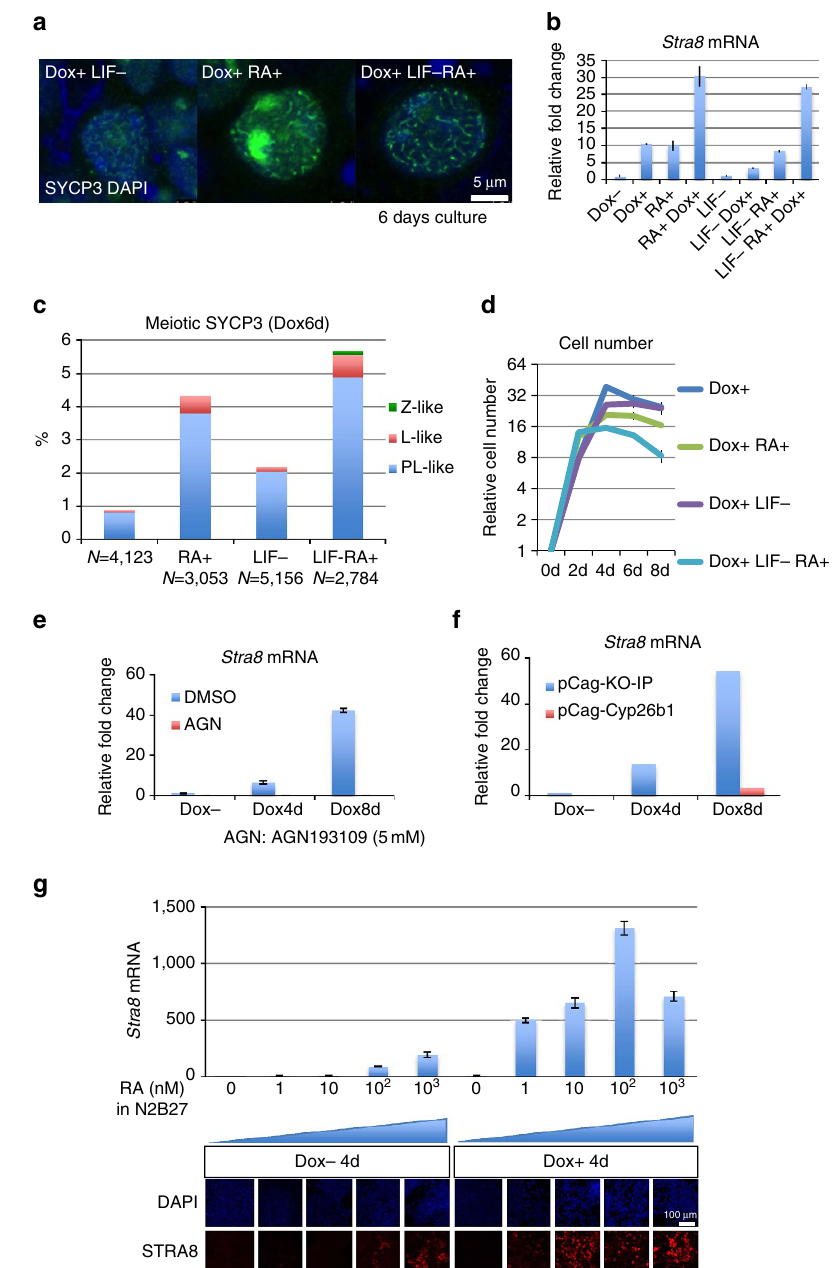
Figure 6 | RA treatment potentiates meiosis-related changes in Max expression-ablated ESCs. ( a ) Representative images of meiosis-like SYCP3-staining patterns in Dox-treated Max -null ESCs cultured with or without RA in the presence or absence of LIF for 6 days. ( b ) Expression levels of the Stra8 gene in Dox-treated Max -null ESCs cultured under the indicated conditions for 6 days. The Stra8 gene expression level in Dox-untreated control Max -null ESCs cultured in the presence of LIF was arbitrarily set to one ( n ¼ 3, means ± s.d.). ( c ) Frequency of meiosis-like SYCP3-staining patterns in Max -null ESCs treated with Dox for 6 days or together with RA in the presence or absence of LIF. ( d ) Effect of RA on the recovery of viable Dox-treated Max -null ESCs cultured with or without LIF. The number of cells at day 0 was arbitrarily set to one ( n ¼ 3, means ± s.d.). ( e ) Quantification of Stra8 mRNA levels in Dox-treated or -untreated Max -null ESCs cultured in the presence or absence of the RA receptor inhibitor AGN for the indicated days ( n ¼ 3, means ± s.d.). ( f ) Effect of the expression of Cyp26b1 on Stra8 expression levels in Max -null ESCs. ( g ) Dose-dependent effect of RA on Stra8 expression levels in Max -null ESCs cultured in N2B27 with no RA as basal medium ( n ¼ 3, means ±